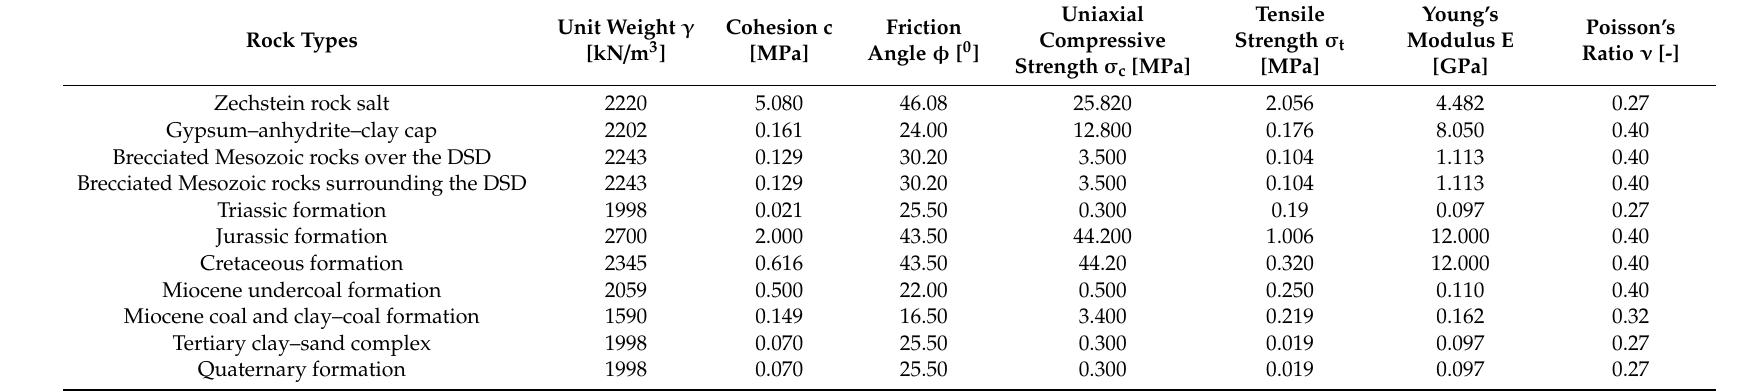
Table 1. Physical and mechanical parameters used in numerical